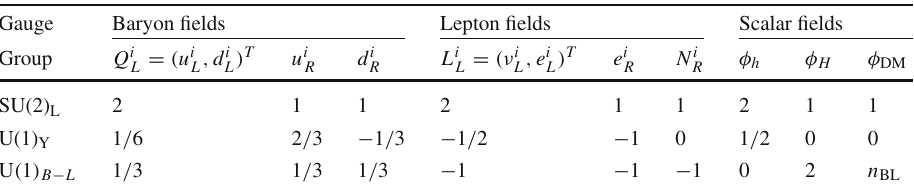
Table 1 Charges of all particles Gauge Baryon fields Lepton fields Scalar under various symmetry groups